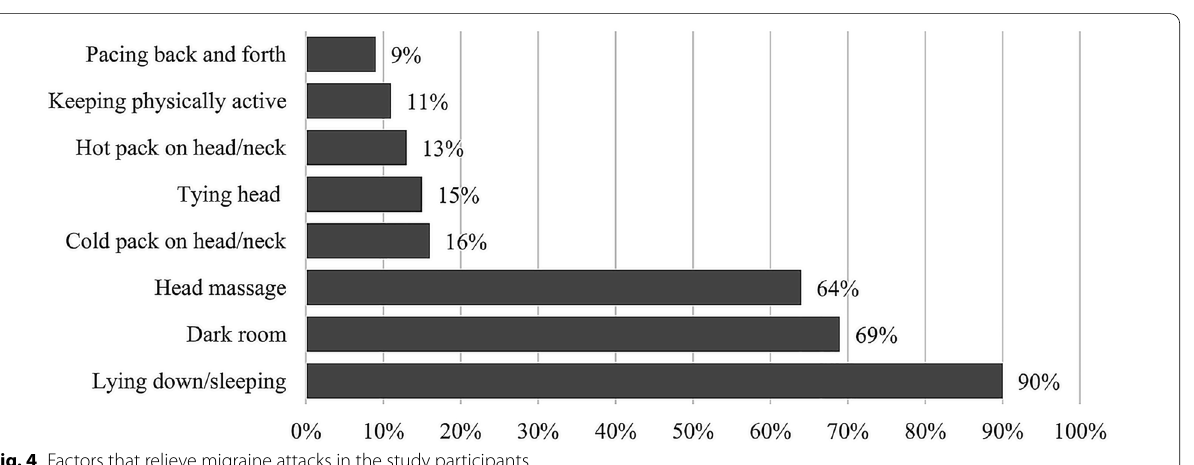
Fig. 3 The top ten migraine attack triggers in the study participants